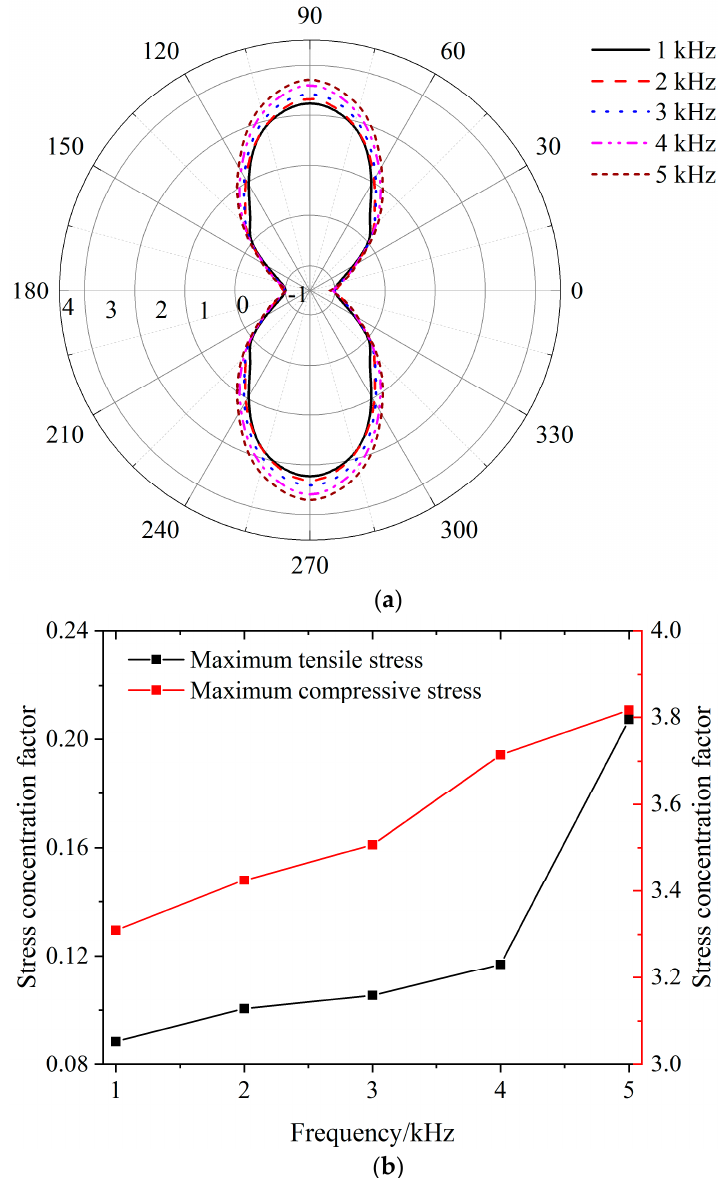
Figure 18. Stress concentration factor under different frequencies. ( a ) DSCF around hole, ( b ) maxi- mum stress concentration factor.